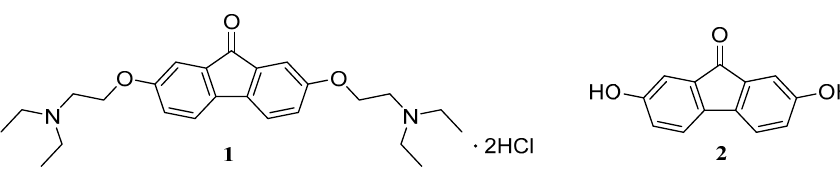
Figure 1. Structures of tilorone dihydrochloride ( 1 ) and 2,7-dihydroxyfluoren-9-one ( 2 ).